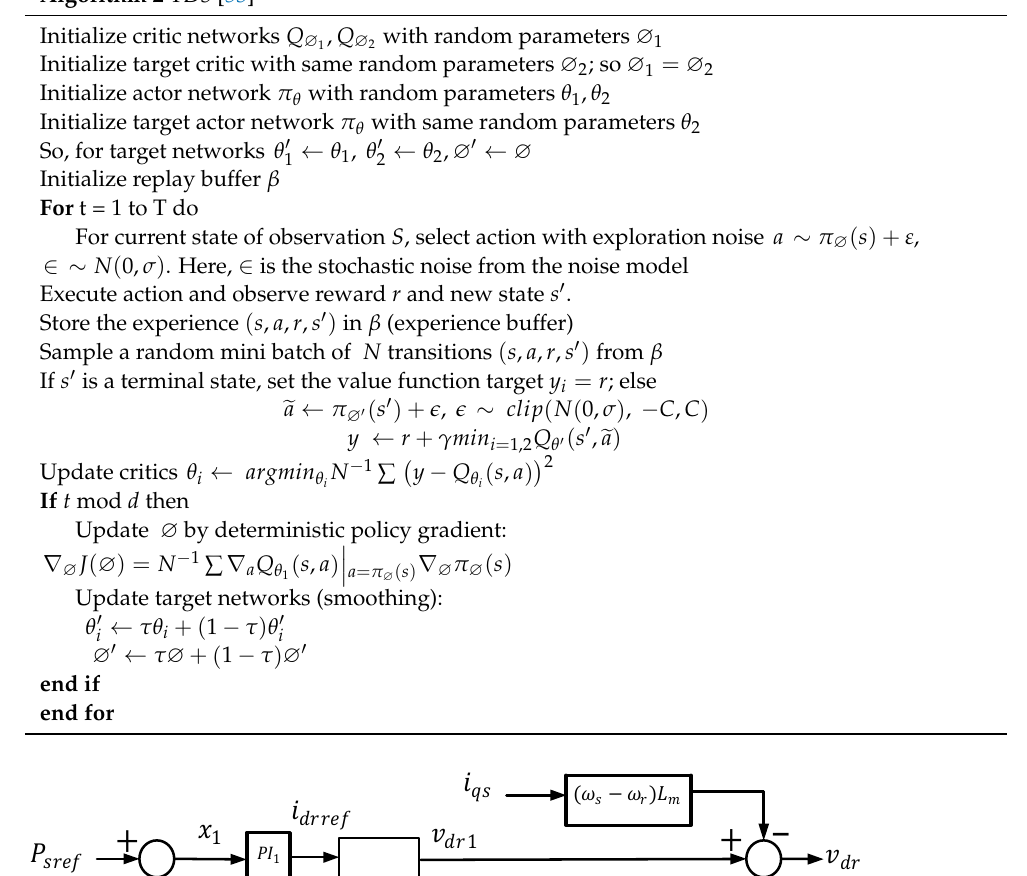
Algorithm 2 TD3 [53]